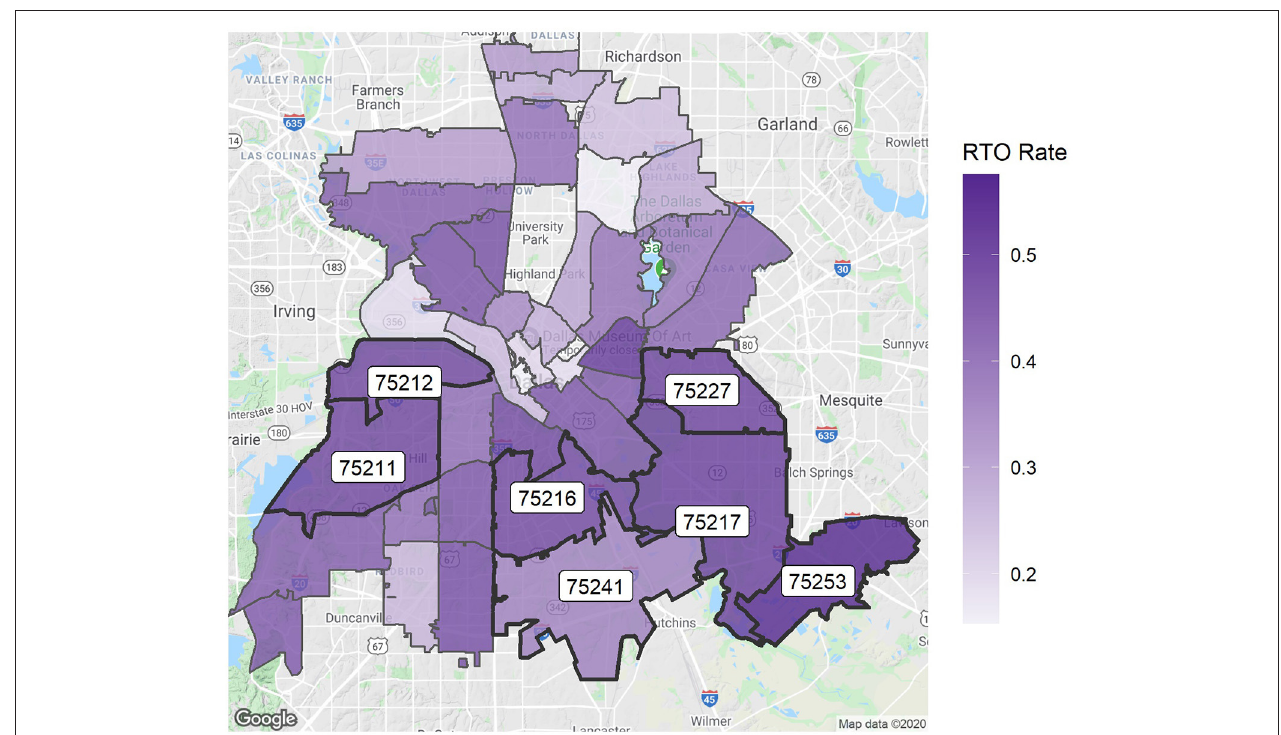
FIGURE 3 | RTO rate per ZIP code. The seven highest-intake ZIP codes are labeled.